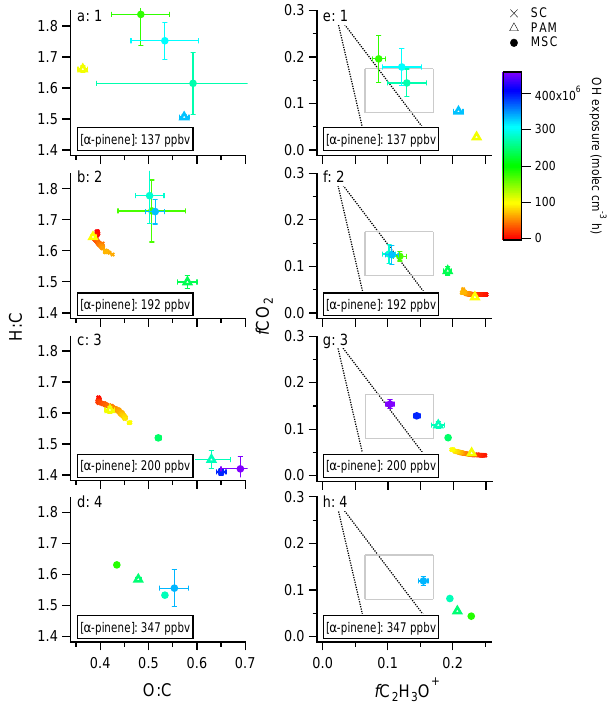
Figure 3. Ratio of H:C as a function of O:C ( a–d , experiments 1– 4 respectively) and the ratio of [CO 2 ] + to the total organic aerosol as a function of the ratio of [C 2 H 3 O] + to the total organic aerosol ( e–h , experiments 1–4 respectively) for each α -pinene experiment. Color scale indicates OH exposure. In (e) – (h) , dashed lines indicate the region in which ambient OA measurements typically lie (Ng et al., 2010) and gray boxes encompass the measurements from Pfaf- fenberger et al.